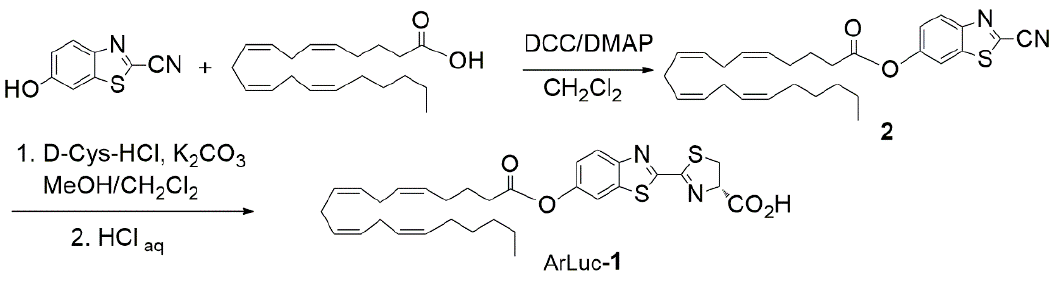
Figure 1. Comparison of luminescence produced by ArLuc- 1 in presence ( ● ) or absence ( ▪ ) of Mon- oacylglycerol lipase (MAGL). Data represent mean ± standard deviation (SD).